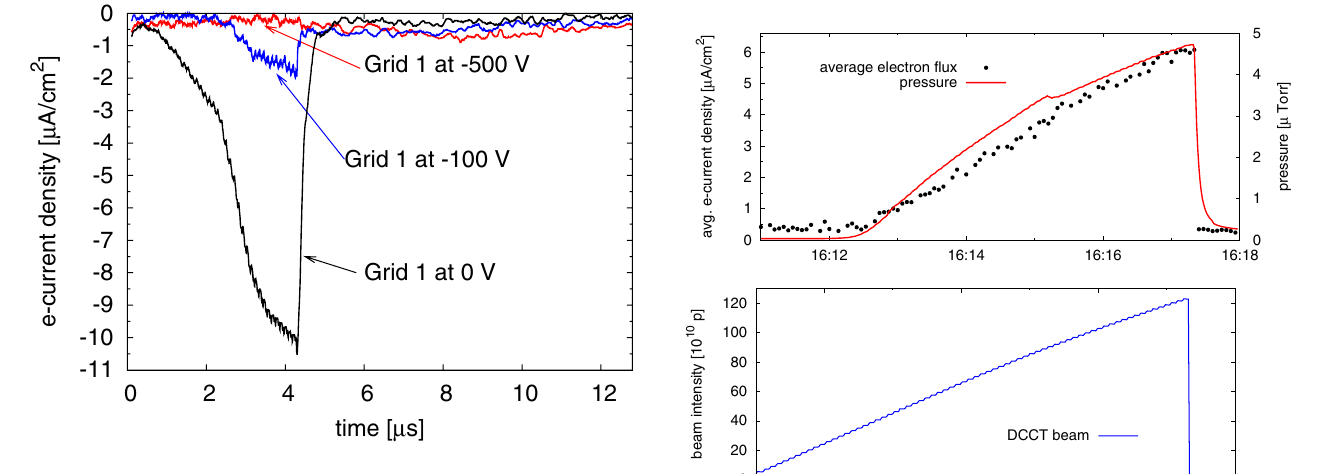
FIG. 8. (Color) Measured instantaneous electron current density into the wall of a train of 43 proton bunches, 108 ns apart, with an average bunch intensity of 1 : 6 (cid:7) 10 11 . With increasing volt- age on grid 1, electrons below certain energies are rejected, allowing the measurement of electron energy spectrum in the cloud [43].